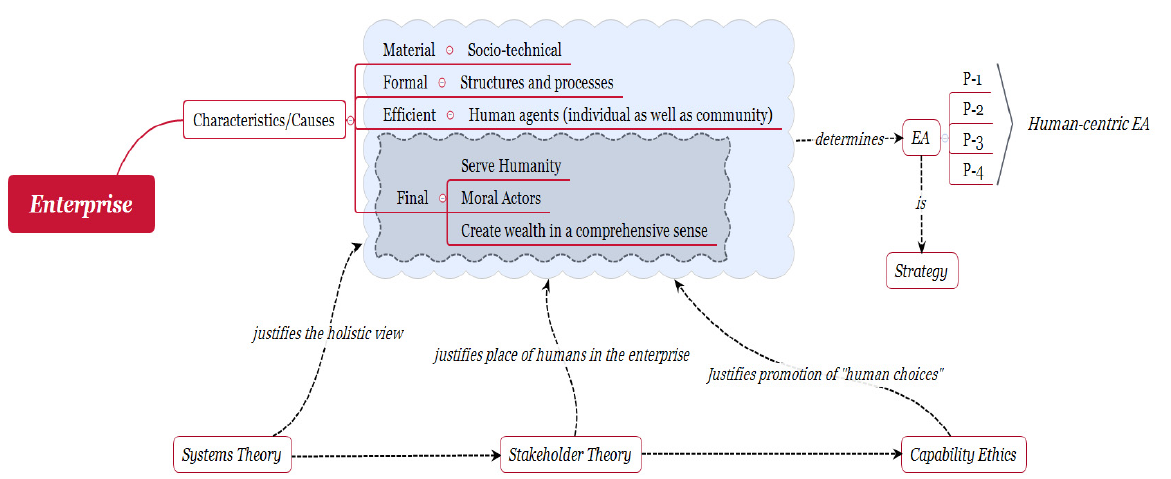
Figure 1. Conceptual flow of the paper.